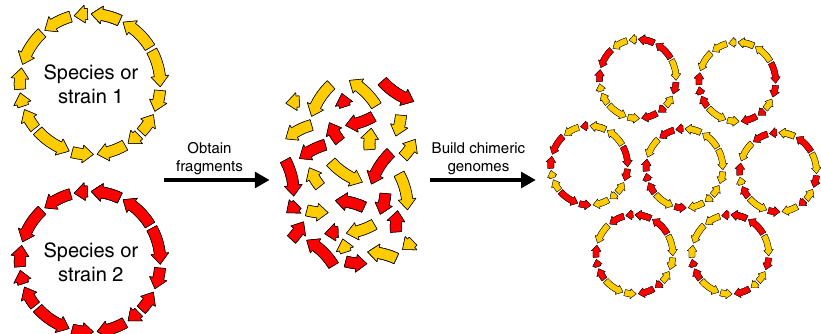
Fig. 5 Chimerism. Synthetic genomic approaches can enable the generation of chimeric chromosomes that contain mosaics of genetic material from two or more strains or species. By generating and screening libraries of chimeric chromosomes, it may be possible to determine the genetic basis of traits that differentiate reproductively isolated organisms.